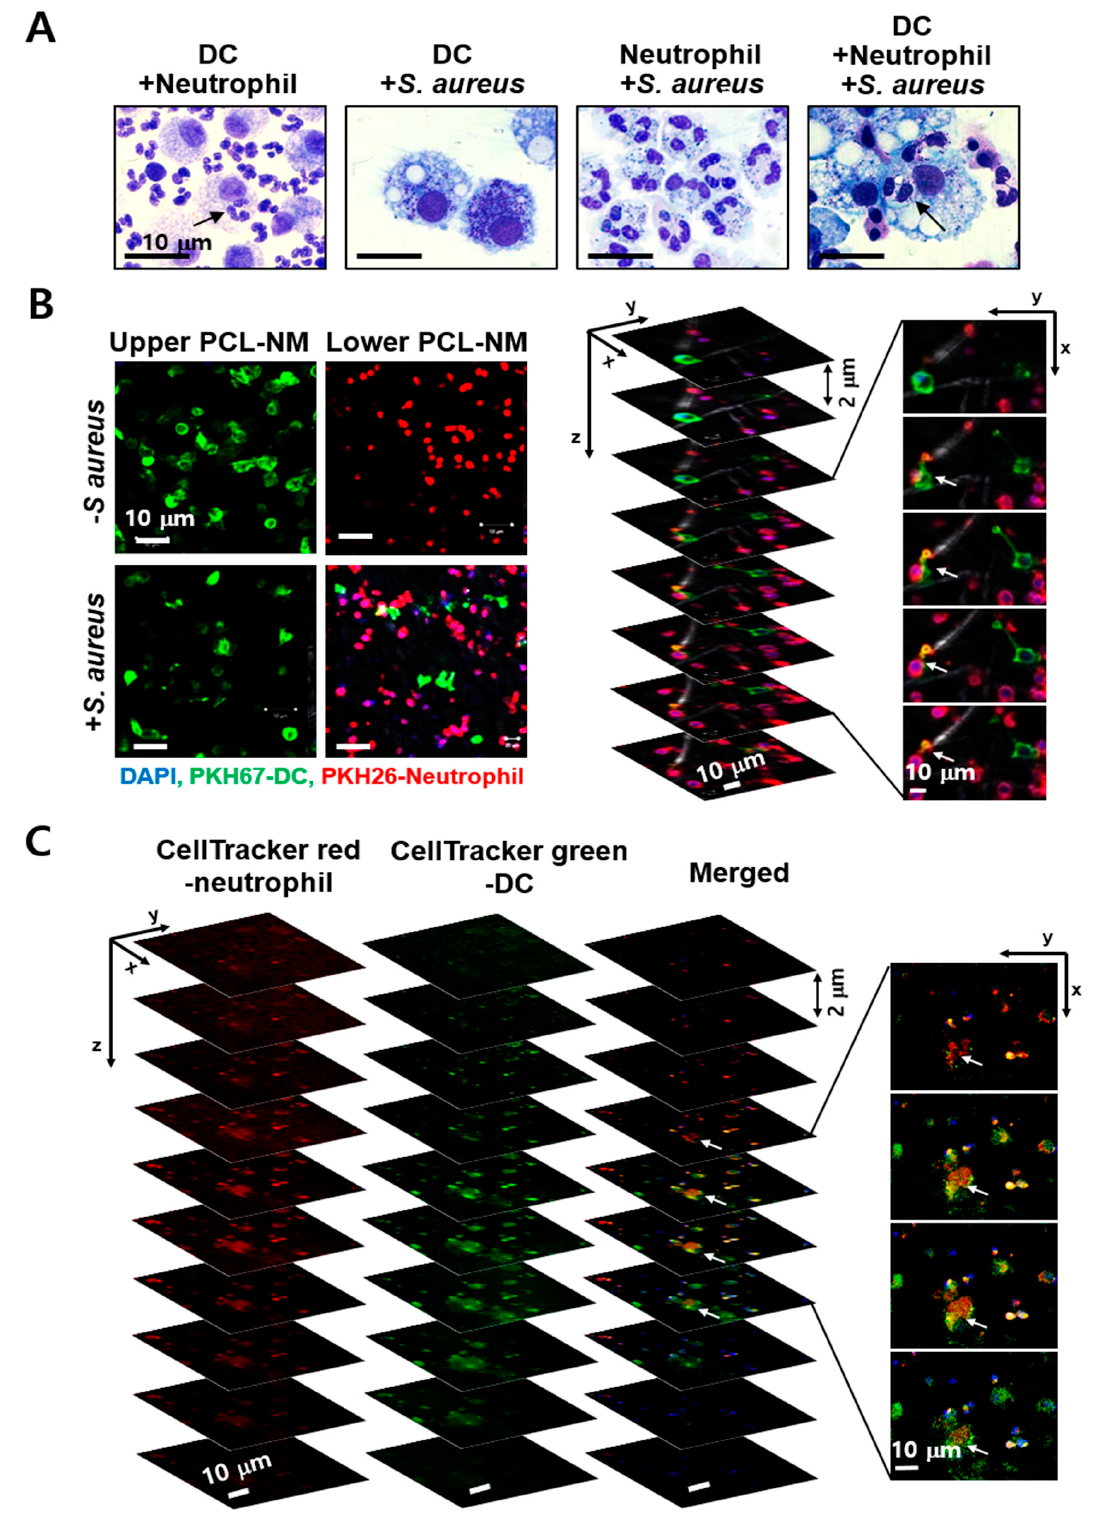
Figure 6. Engulfment of neutrophils by DCs in 2D and 3D culture conditions. ( A ) DCs (2 × 10 5 ) and/or neutrophils (1 × 10 6 ) were cultured with or without S. aureus (5 × 10 6 CFU) for 6 h in culture dishes and stained with Giemsa solution ( n = 3). Arrows indicate live neutrophils inside of DCs. ( B ) PKH26-labeled neutrophils (2 × 10 6 ) were cultured for 2 h with or without DAPI-stained S. aureus (2 × 10 7 CFU) in the lower PCL-NM. PKH67-labeled DCs (2 × 10 5 ) in the upper PCL-NM were cultured for 4 h with bacteria and neutrophils in the lower PCL-NM ( n = 3). Green-fluorescent spots were detected in the lower PCL-NM (in the left panel). The right panel depicts focus-stacking images of the lower PCL-NM. ( C ) CellTracker green-labeled DCs in the upper PCL-NM were cultured with CellTracker red-labeled neutrophils and DAPI- stained bacteria as described in figure B ( n = 3). Arrows indicate red-fluorescent spots inside of green-fluorescent areas in the lower PCL-NM. Images show stacks of 2 µm in thickness from the top to bottom.